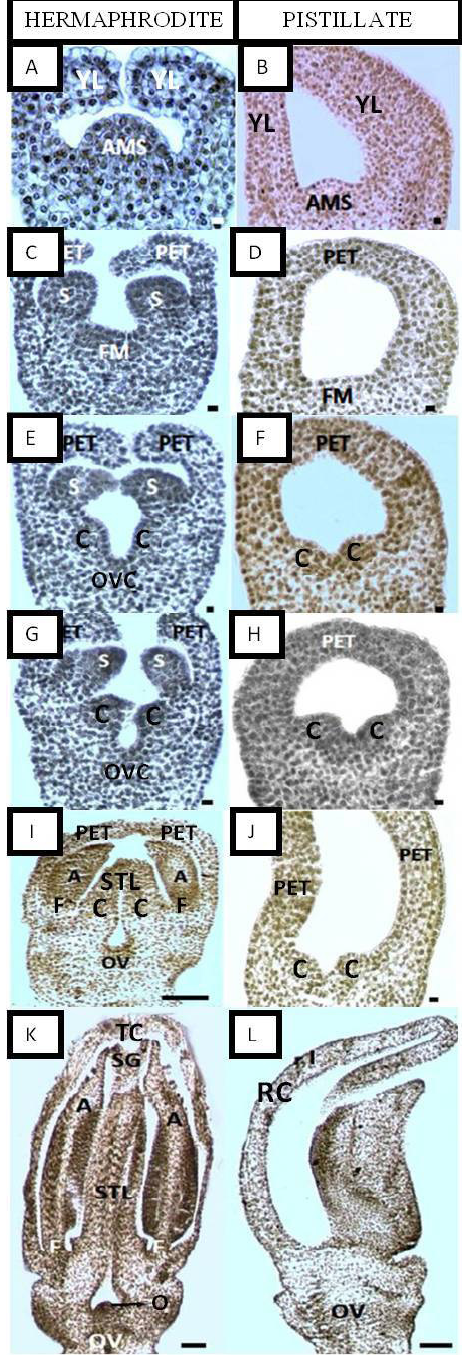
Fig. 2. Comparative floret development of hermaphrodite (left) and pistillate (right) florets in H. annuus (in longitudinal sections). A. Apical meristem initiation; B. Apical meristem initiation; C. Floral meristem and initiation of petal and stamen primordia from floral meristem; D. Floral meristem and initiation of petals from floral meristem; E. Lengthening petal primordia and two carpel primordial starting to differentiate out of floral meristem below lengthening stamen primordia; F. Lengthening petal primordia and two carpel primordia differentiate out of floral meristem; G. Stamens in which anther and filament differentiation start and the bent structure that the carpel primordia generated above ovary; H. Stage where carpel primordia development stops; I. Anthers starting to expande, short filaments, ovary and style that is generated when carpel primordia lengthen; J. Carpel primordia stopping development and petal primordial continuing to extent; K. Long and wide anthers, filaments, stigma with two parts, style, ovary with an ovule protruding out of placenta, tubular corolla in mature hermaphrodite flower; L. Carpel primordia disappeared and radial corolla in a mature pistillate flower. A: Anther; AMS: Apical meristem; C: Carpel; F: Filament; FM: Floral meristem; O: Ovule; OV: Ovary; OVC: Ovary cavity; PET: Petal; S: Stamen; SG: Stigma; STL: Stylus; YL: Youthful leaves. Bar: 10 μm (A-H), 100 μm